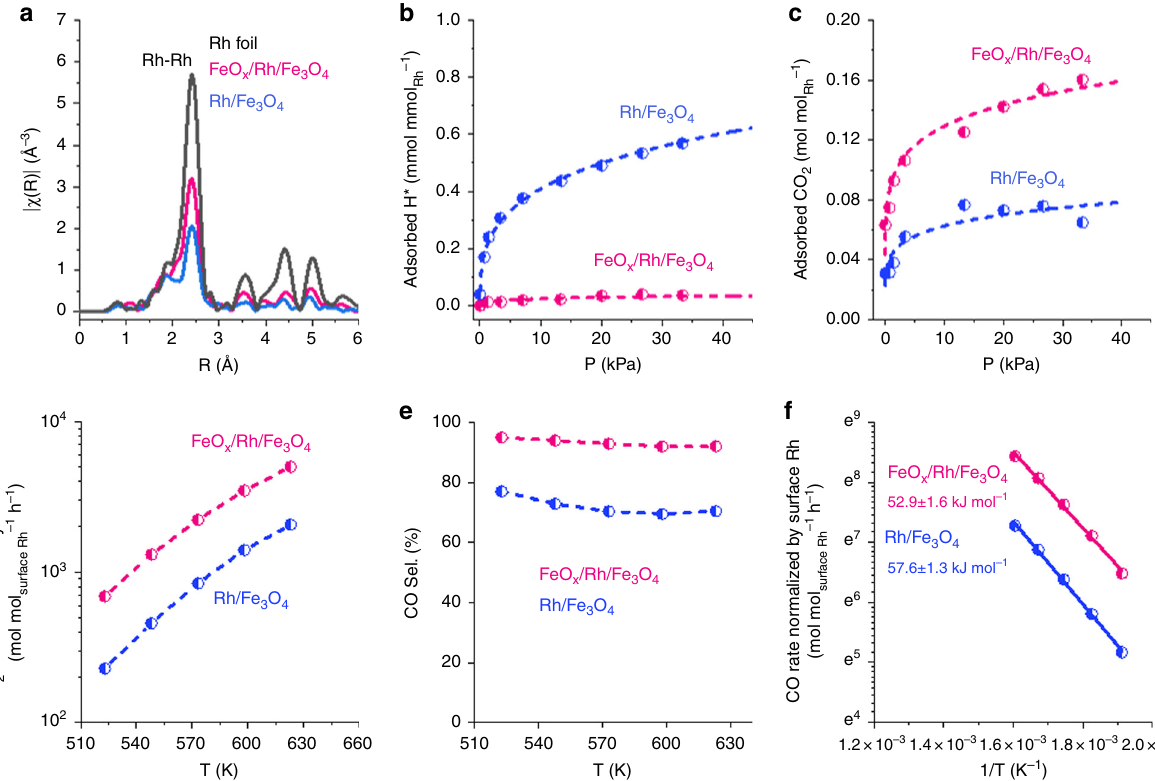
Fig. 4 Characterizations and catalytic performance showing the impact of the FeO x overlayer on CO 2 reduction. Rh K-edge EXAFS spectra ( a ), isotherms of H 2 and CO 2 chemisorption ( b , c ), CO 2 conversion rates ( d ), and CO selectivity for CO 2 conversion ( e ), and the Arrhenius plots for CO 2 reduction to CO ( f ) for FeO x /Rh/Fe 3 O 4 and Rh/Fe 3 O 4 . Reaction conditions: 523 – 623 K, 101 kPa, CO 2 /H 2 /He = 7/28/105 mLmin − 1 (gas hourly